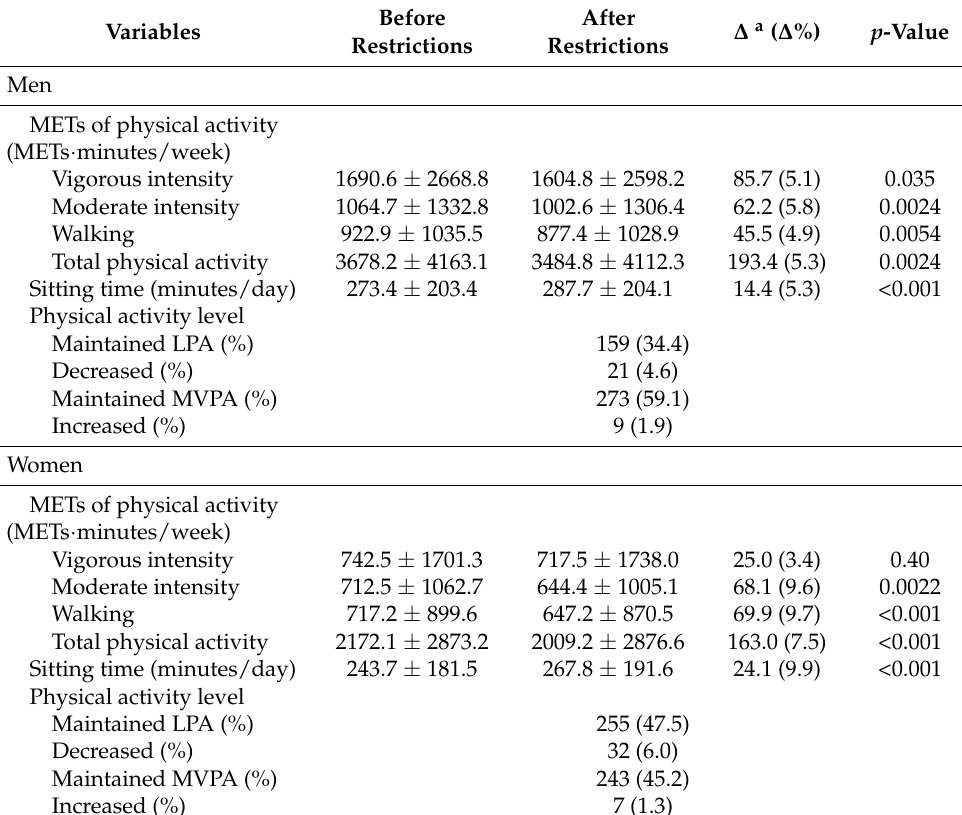
Table 2. Differences in physical activity before and after the onset of COVID-19 restrictions, assessed by self-reported